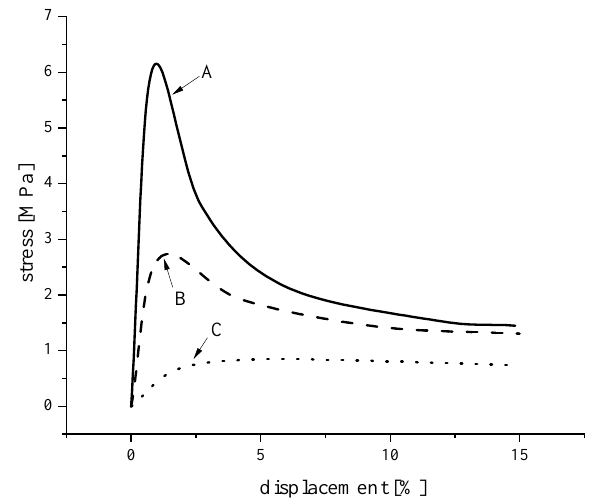
Figure 7. Schematic stress–displacement curves (modes of failure: A—high force maximum; B— medium force maximum; C—constant, low force